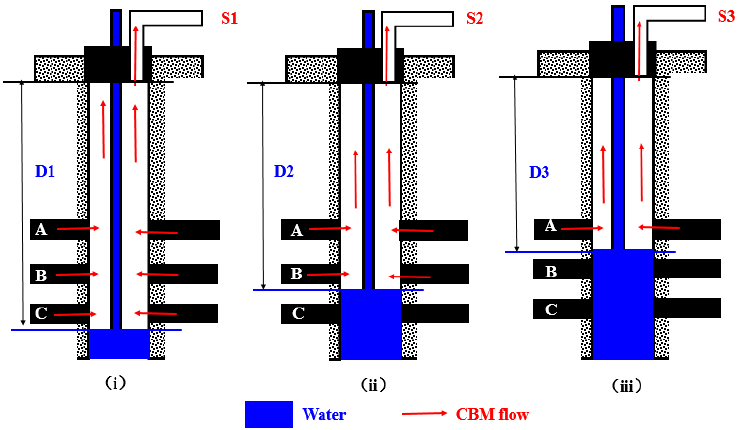
Figure 1. Simplified procedures for determining gas production and composition of each coal seam (groups A, B and C) from a multi-seam coalbed methane (CBM) well.